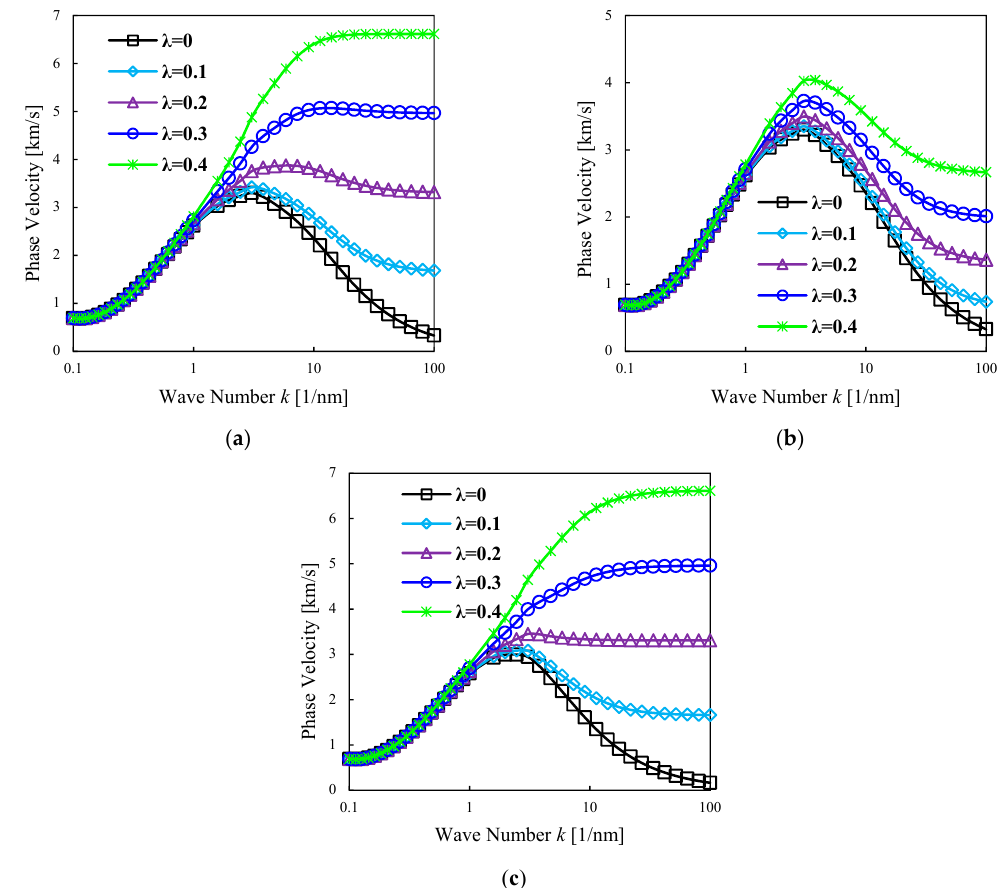
Figure 5. Phase velocity of FG doubly-curved nanoshell vs. the wave number for different non-local and strain gradient parameters. R 2 = R 1 = 50 × h , n = 2, ξ = 0.1; ( a ) µ 0 = 0.1, µ 1 = 0.2, ( b ) µ 0 = 0.1, µ 1 = 0.5, ( c ) µ 0 = 0.2, µ 1 =